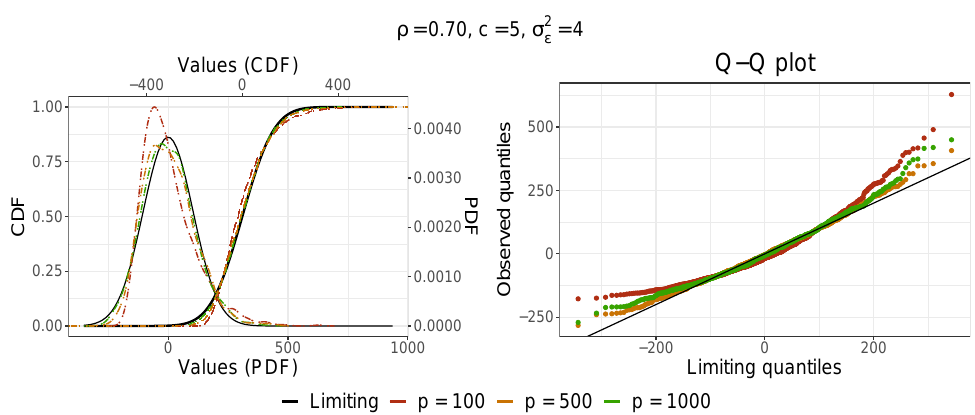
Figure 5. Comparison of the PDF and CDF ( left ) and the corresponding Q-Q plots ( right ) after 1000 replications from the Monte Carlo simulation of the statistic (80) with the limiting distribution N ( 0, s 2 ) by the Corollary 2 (in black) for (cid:36) = 0.7, c = 5, σ 2 = 4 and p = 100,500,1000. ε